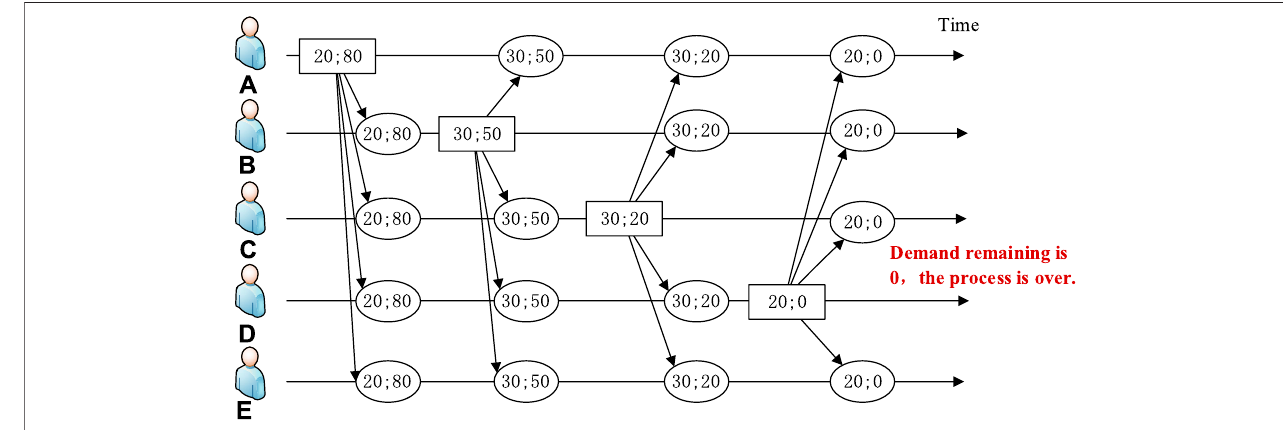
FIGURE 7 | Illustration of user participation in the demand response process.